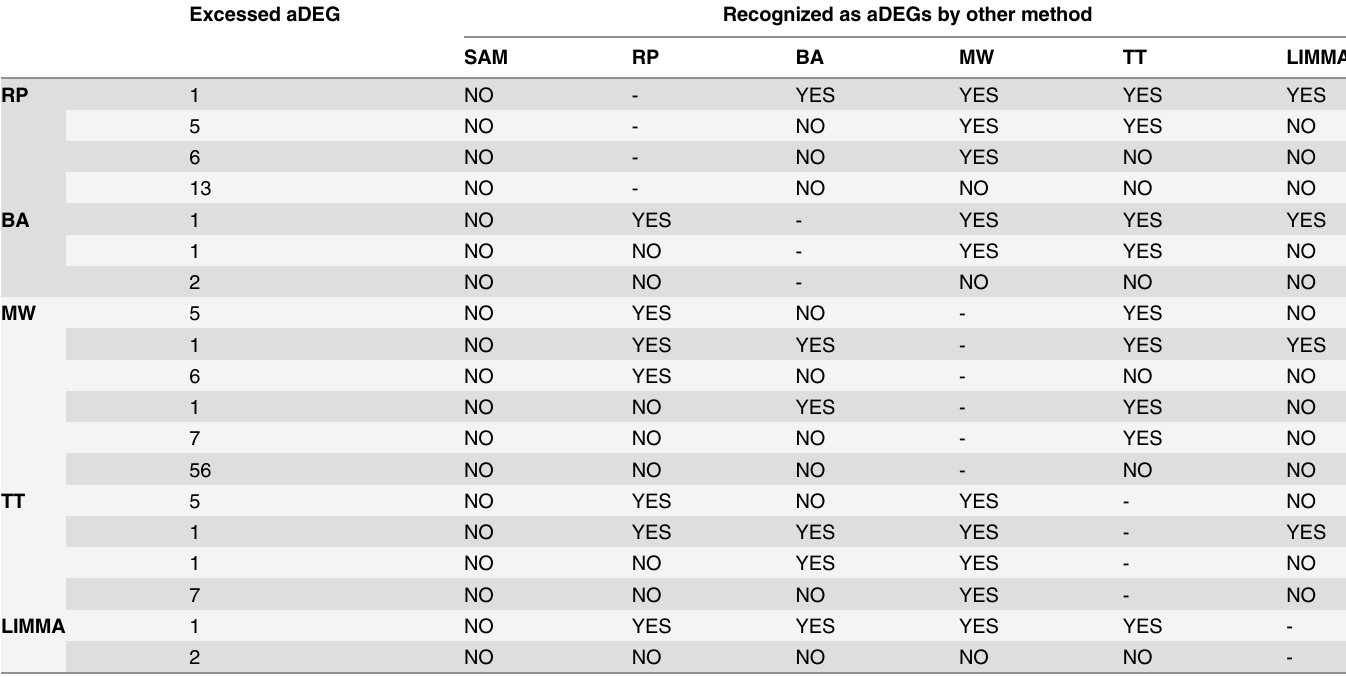
Table 8. Summary of excessed aDEGs by each method. Excessed